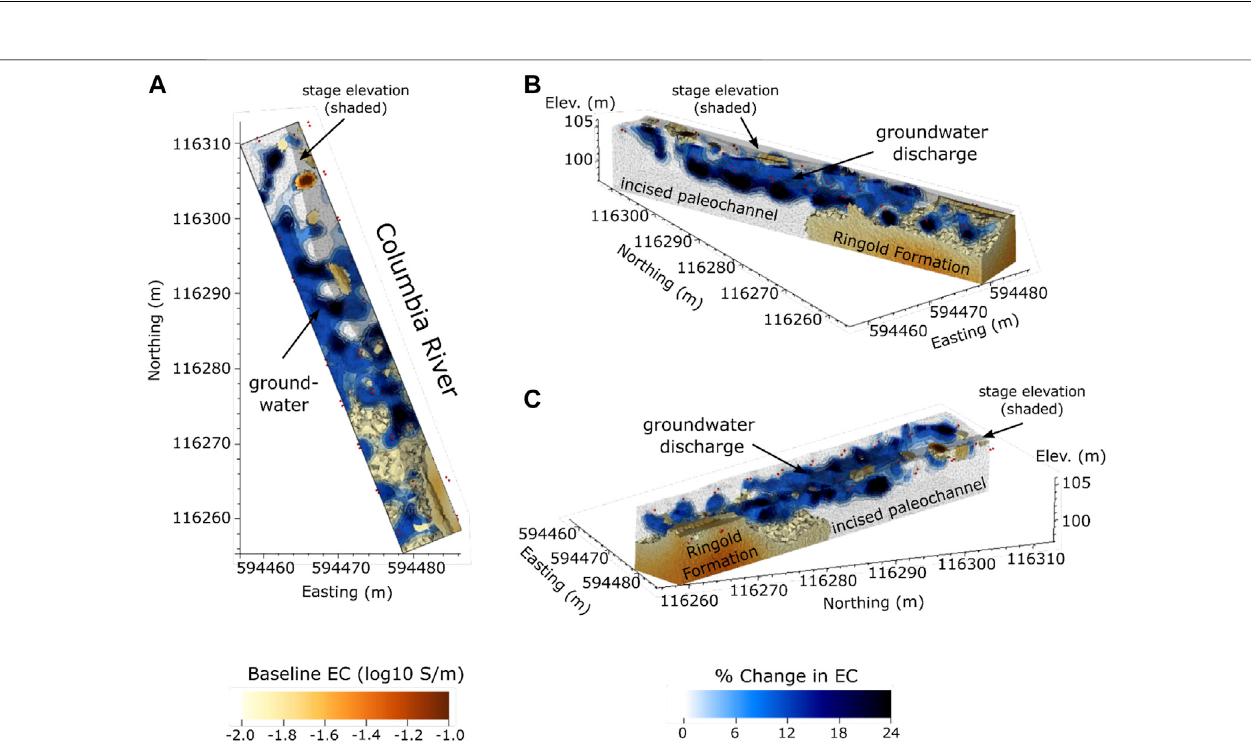
FIGURE7|(A) Planview, (B) obliqueviewfromshorelinetoriver, (C) obliqueviewfromrivertoshorelineofthechangeinbulkconductivityfromhighstageatt=0 h to low stage at t = 43 h. Changes in bulk EC are represented as semi-transparent isosurfaces, and are diagnostic of where groundwater has replaced river water. Isosurfaces are superimposed on the baseline ERT high-conductivity zone assumed to be the lower permeability Ringold Formation (see Figure 6 ). Note that Ringold Formation elements do not obfuscate any change in EC isosurfaces (i.e., there are no signi fi cant changes within the Ringold Formation). An animation of the full 3D difference time series is included in the supplementary material to this